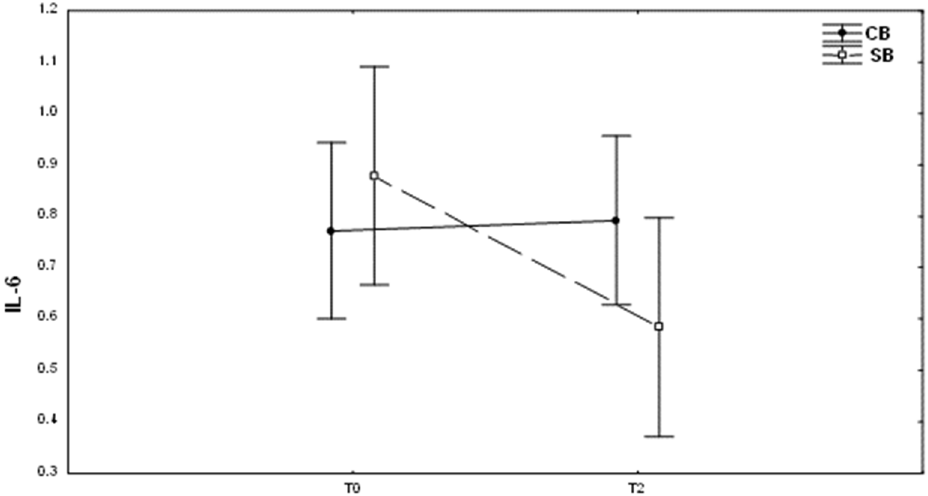
Figure 3. Changes in IL-6 (mean ± SD) levels at different times (T0, baseline; T2, after 2 months of the treatment) in patients with conventional brackets (CB) and self-ligating brackets (SB).